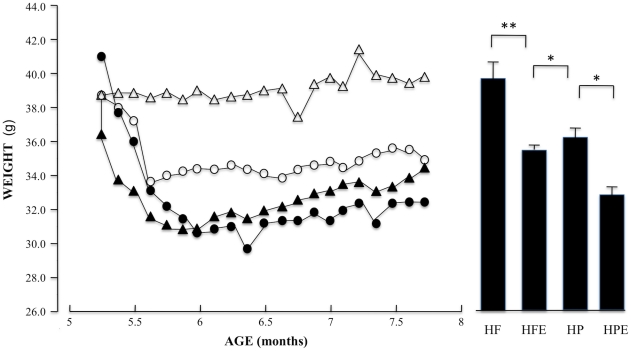
Comparisons of total body weight between groups.Mice were weighed 3 times per week in all groups and mean weight calculated (n = 10 per group). Symbols as in Figure 2. For bar graphs on the right each value represents the mean of body weights during the exercise period ± SEM; data was analyzed by two-way ANOVA as described in Methods; analysis of simple effects; **p<0.001; *p<0.01).